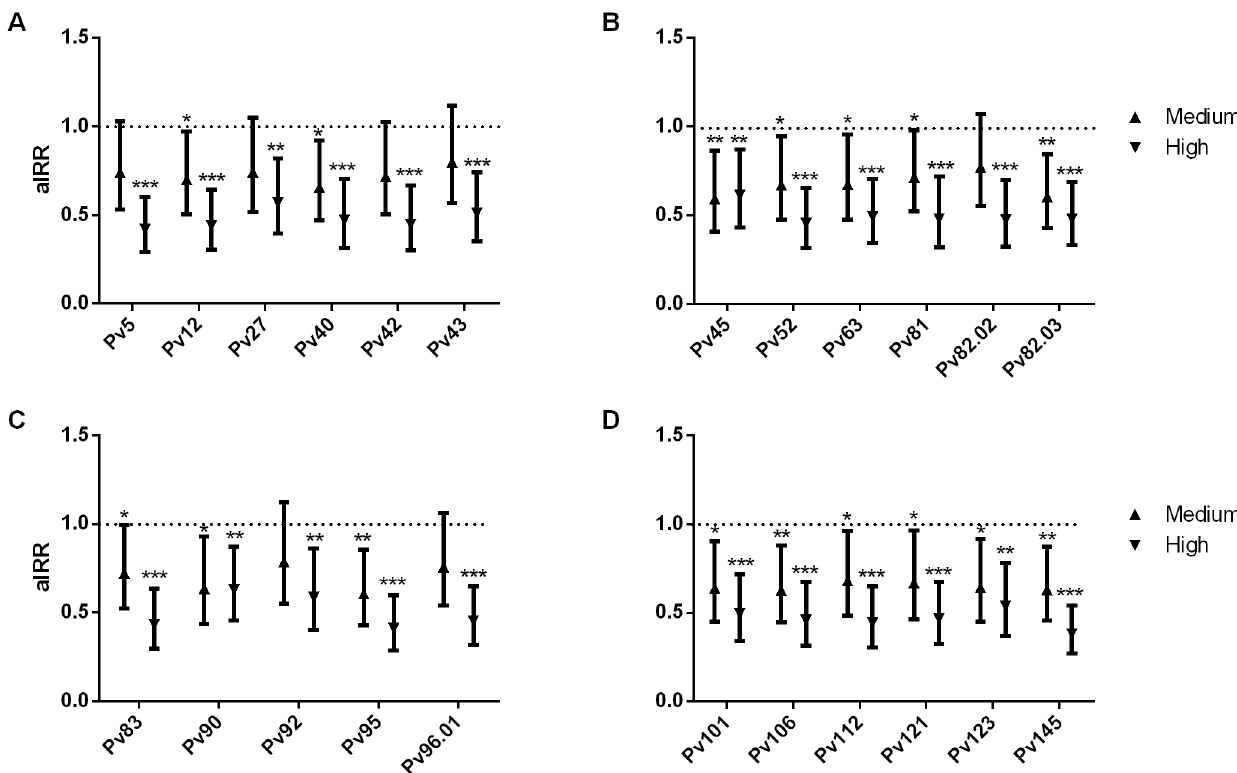
Fig 3. IgG to P . vivax coiled coil antigens and risk of clinical malaria in PNG children. Data are plotted as incidencerate ratios and 95% confidenceintervals, adjusted for exposure(molFOB), age, season, and villageof residency.P values < 0.05 were considered